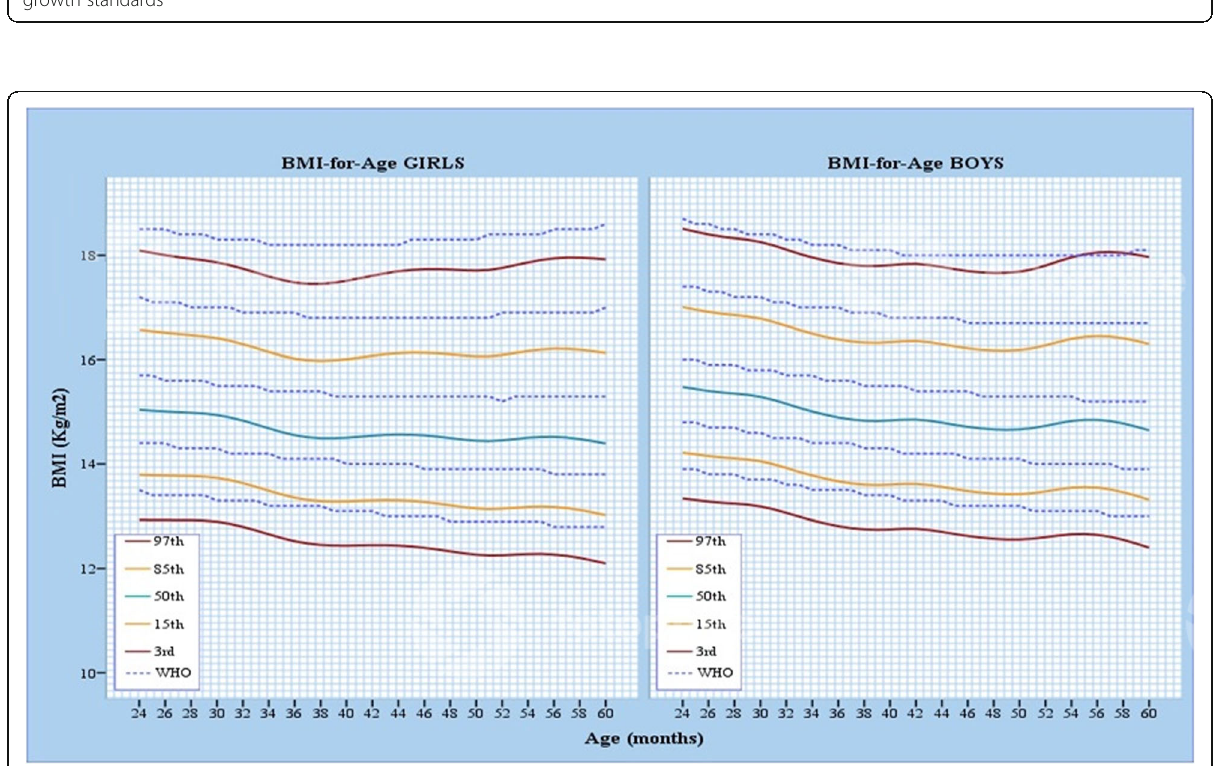
Fig. 2 Weight percentiles (P3, P15, P50, P85, and P97) by age for girls and boys ages 2 – 5 years who were born in Isfahan compared to the WHO growth standards